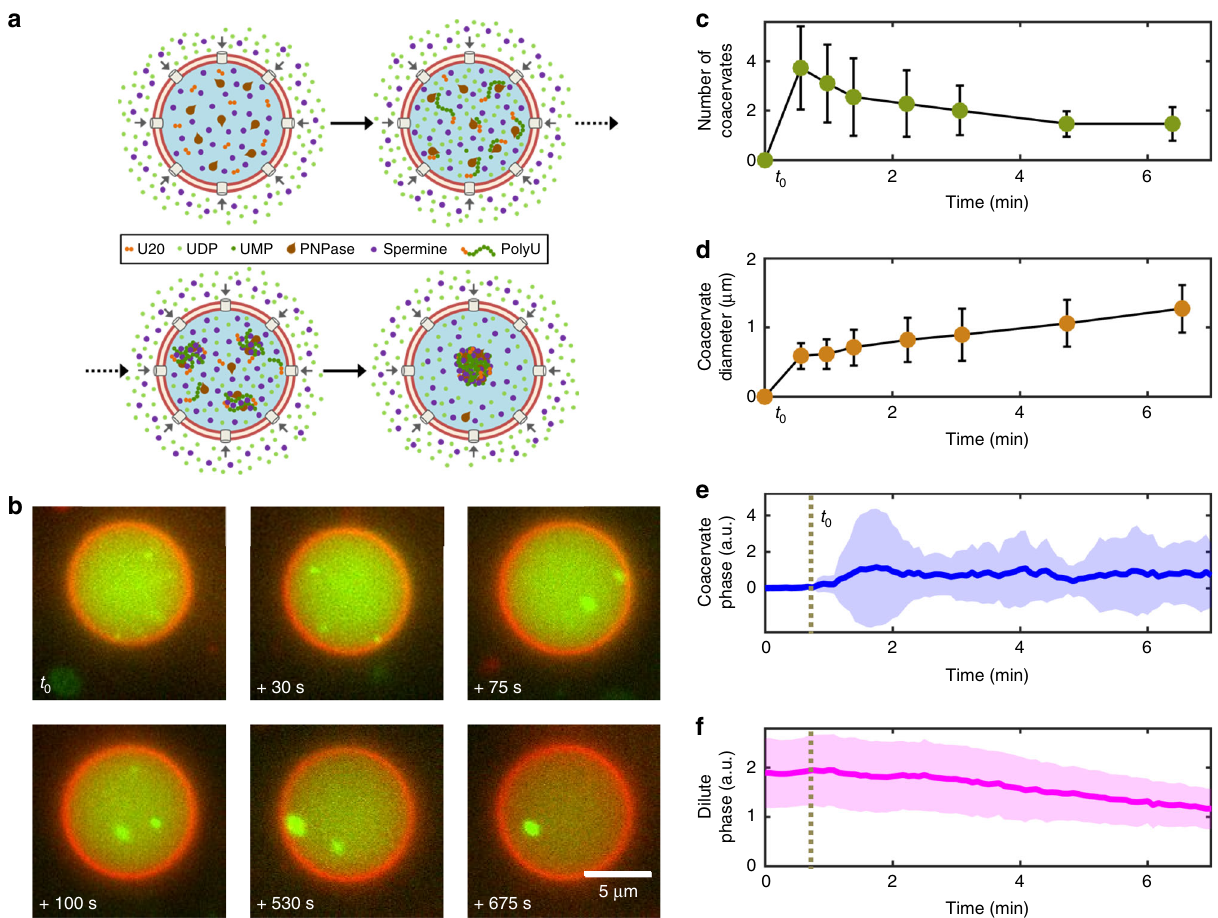
Fig. 3 Enzymatically catalyzed polyU/spermine coacervate formation inside liposomes. a A schematic showing polyU/spermine coacervation within a liposome. UDP diffuses inside the liposome through α -hemolysin pores and is consumed by the enzyme PNPase to elongate encapsulated cy5-U20 seed oligomers. The formed polyU RNA further interacts with spermine to form polyU/spermine coacervates, which fuse together to form a single condensate over time. b Time-lapse fl uorescence images (red: lipid bilayer; green: cy5-U20) showing polyU/spermine coacervation process inside a liposome.